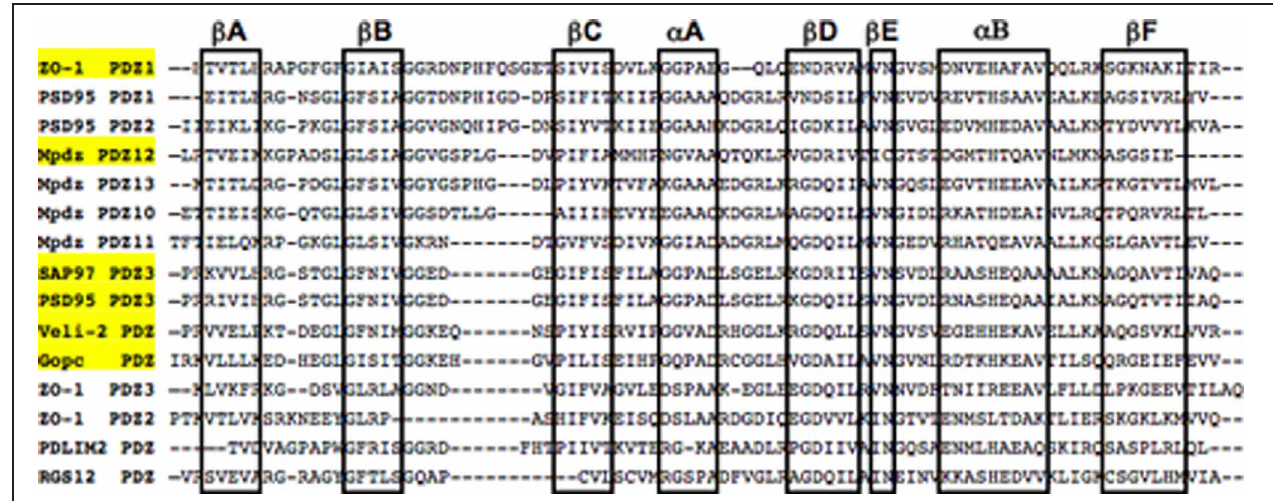
PDZ domains interacting with G γ 13 are highlighted in yellow. Note that the stretch of amino acids present between the β B and β C sheet is of variable length between the various binding partners of G γ 13 thus making it unlikely that this region plays a critical role in the interaction as suggested by Li et